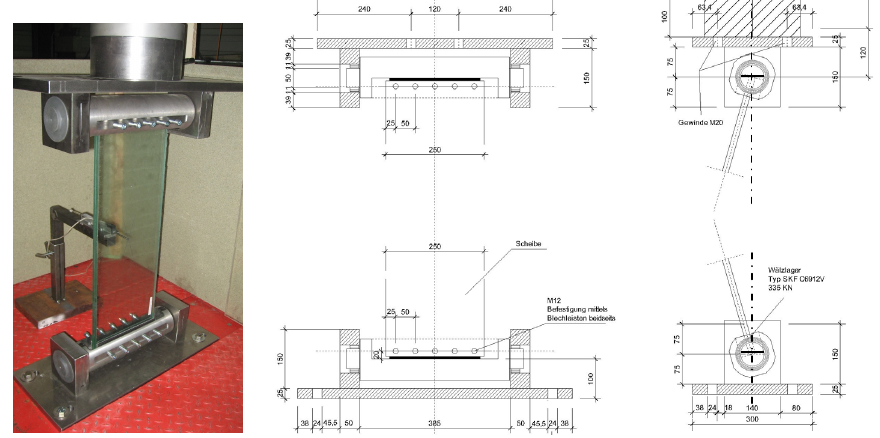
Figure 5: Experimental set-up for buckling of glass-panes according to [2].